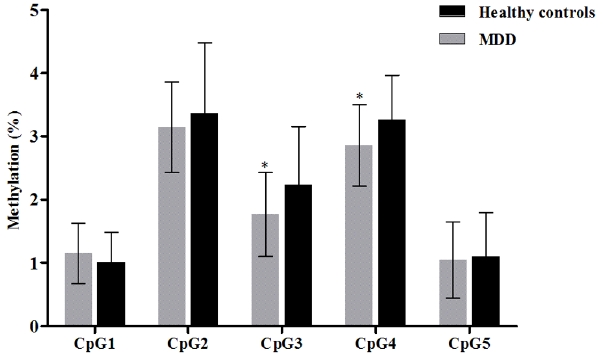
Figure 1. Comparison of NR3C1 methylation between patients with major depressive disorder and healthy controls, mean (SD). * p , 0.01.